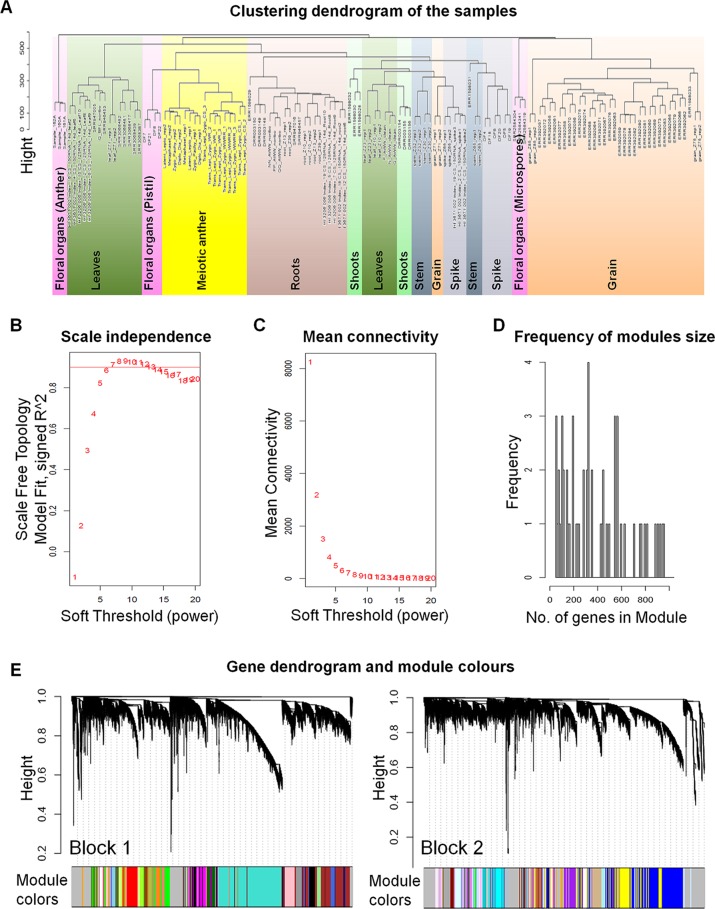
The weighted gene co-expression networks analysis (WGCNA). (A) Clustering dendrogram of 130 samples from different types of tissues. The sample clustering was based on the expression data of the genes expressed during meiosis. (B) Analysis of the scale-free fit index for various soft-thresholding powers (β). A scale-free network is a network with the property that the number of connections k originating from a given node exhibits a power law distribution P (k) ∼ k
−
ɤ (where 2 < ɤ < 3). The red line indicates the scale-free topology fit index (of 0.9) for which the network obeys scale free network property. The soft power threshold used in constructing the weighted gene co-expression networks was chosen as the first power to exceed the red line (then β = 7). (C) Analysis of the mean connectivity for various soft-thresholding powers. (D) Number of genes in the modules with their frequency. (E) Dendrogram of the analyzed genes (60,379 genes) clustered based on a dissimilarity measure of topological overlap matrices (1-TOM). Blockwise dendrogram was obtained using average linkage hierarchical clustering with maximum block size of 46,000 genes. Modules were identified using height cut off equal to 0.15 with minimum module size of 30 genes. The different color modules correspond to the branches of the dendrogram.